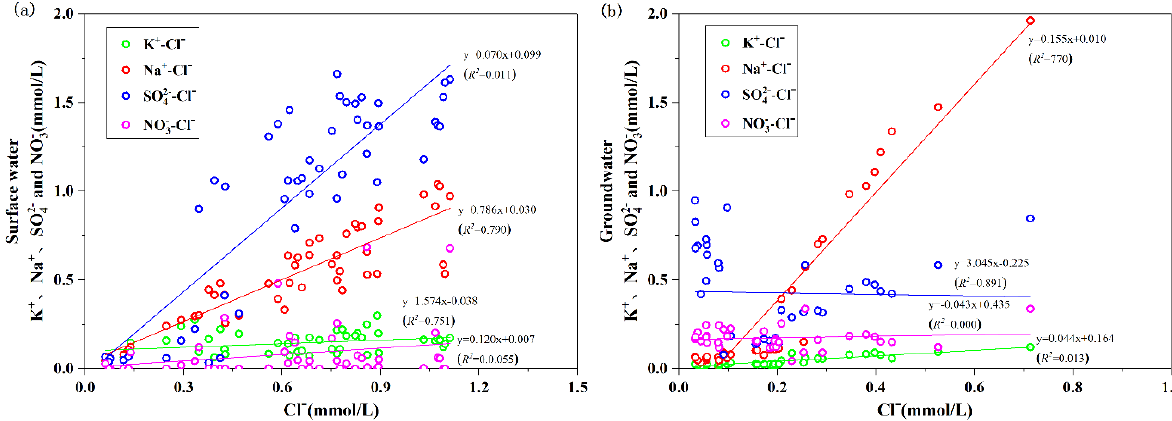
, and NO − respectively in surface water ( a ) and 4 3 3 4